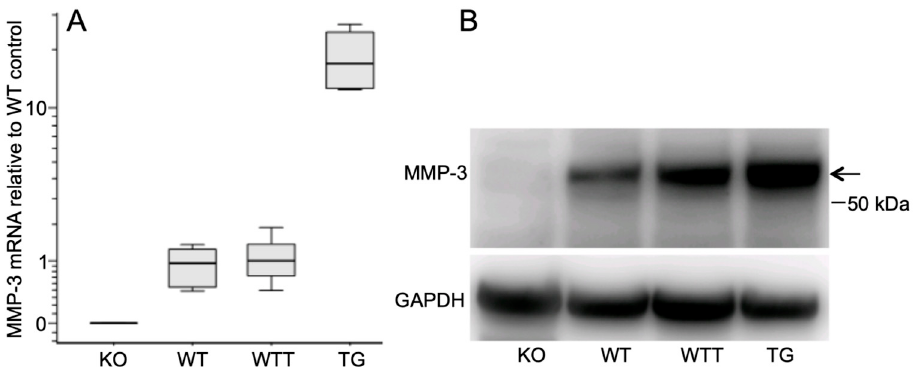
Figure 1. MMP-3 expression in native mouse skin. ( A ) MMP-3 mRNA levels determined by qPCR analysis. Boxes represent the 25th–75th percentile, whiskers the 5th–95th percentile and the horizontal lines within the boxes indicate the median values. ( B ) Representative western blot of six independent experiments of MMP-3 protein expression. Loading was normalized to the total protein (30 µ g / lane) of the tissue extracts. GAPDH indicates the loading / transfer of proteins to the PVDF membrane. The arrow indicates the latent MMP-3 at 56 kDa. The position of the 50 kDa molecular weight marker is indicated to the right. KO (BL10), n = 5; WT (BL10), n = 5; WTT (FVB), n = 3; TG (FVB), n = 4.